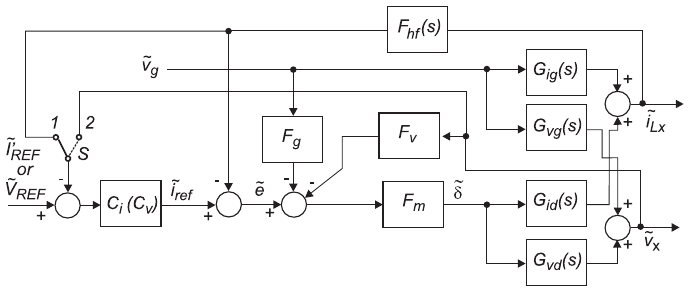
Figure 9. Block diagram of the BM DC–DC converter control scheme.